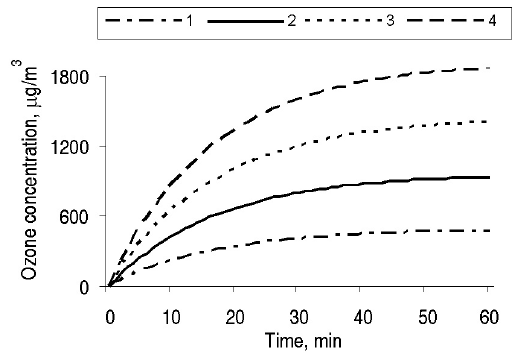
Fig 3. Simulated ozone concentration at four different levels of copying intensity